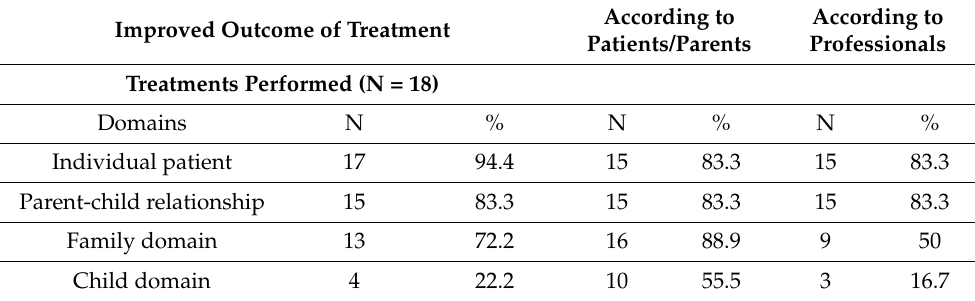
Table 4. Improved outcome of multidisciplinary treatments of an integrated family approach in mental health care according to parents and professionals. Improved Outcome of Treatment